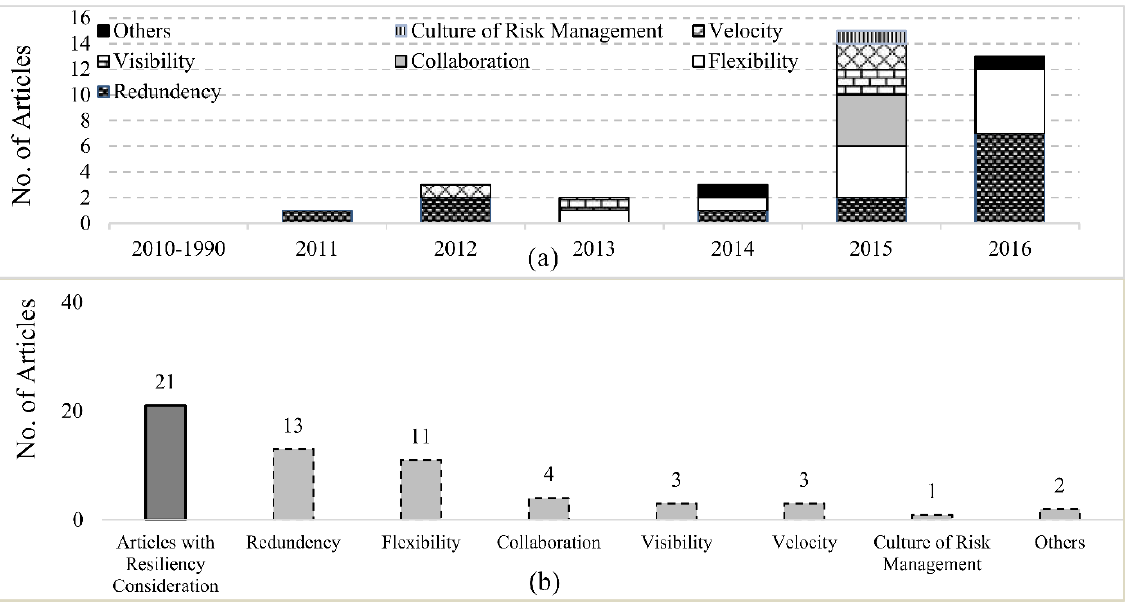
Figure 8. Frequency of different resilience strategies a) over time and b) by each strategy